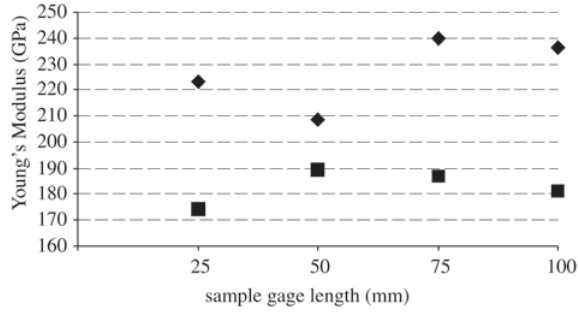
Figure 8. Young’s modulus for carbon fibres. (u) assuming ideal Hookean behaviour, (g) corrected Young’s modulus according to ASTM D 3329M.